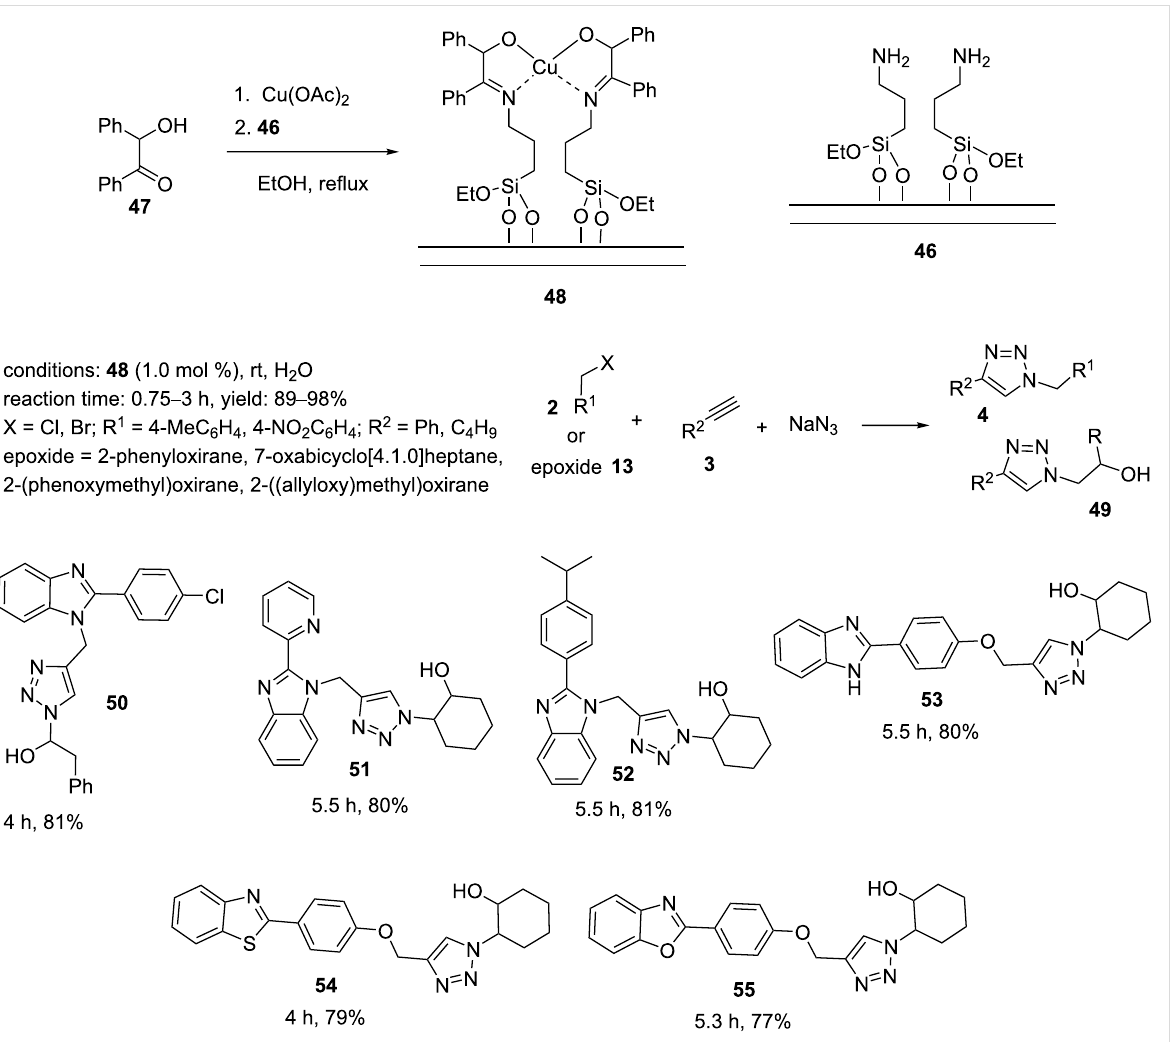
Scheme 8: Synthetic route to the catalyst 48 and catalytic application of 48 in “click”